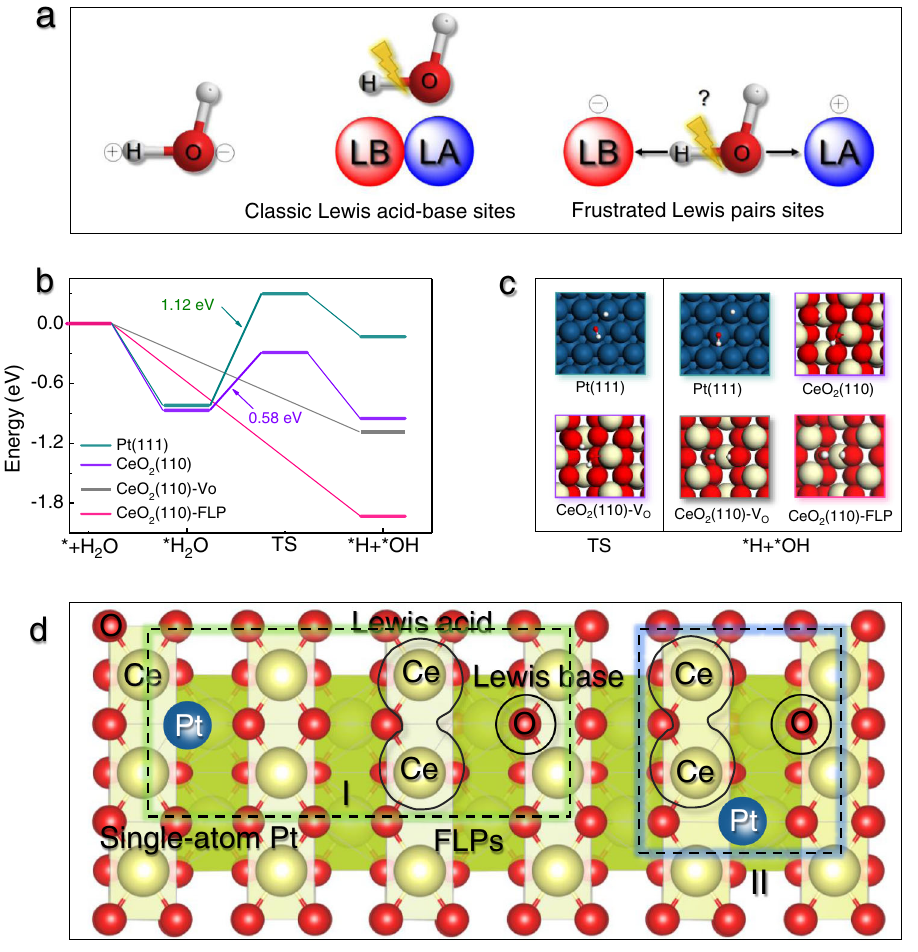
Fig.1|Catalystdesign.a SchemeofH 2 OactivationonclassicLewisacid-basesites and FLPs. b Energy barrier and c adsorption con fi guration of H 2 O activation on various actives sites. d The designed dual-active sites of single-atom Pt and FLPs.